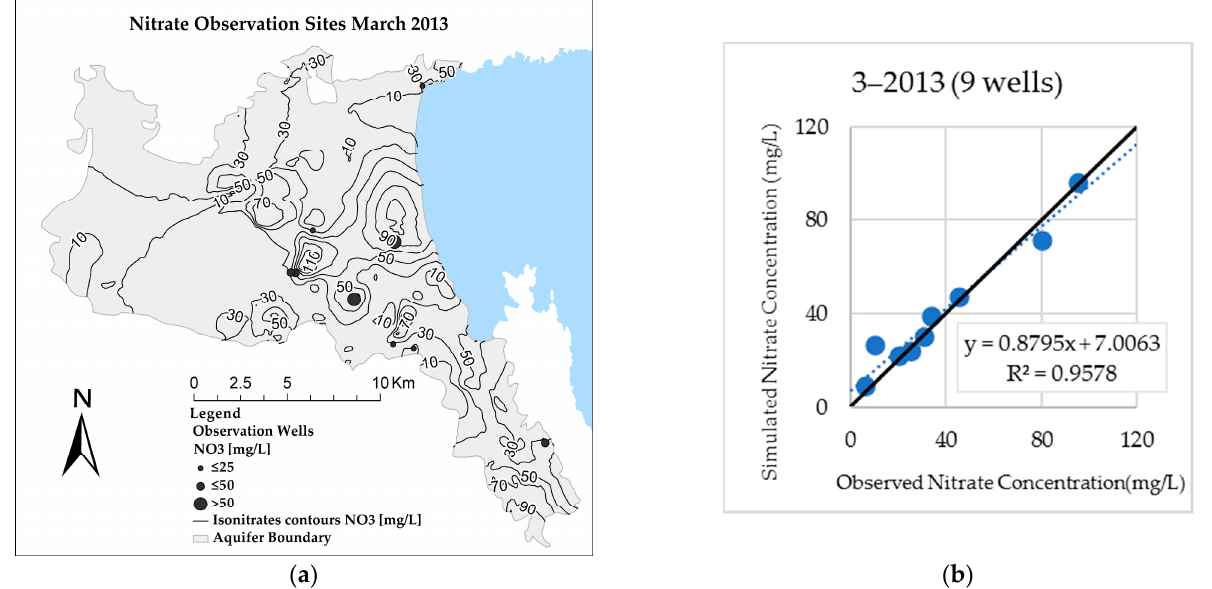
Figure 19. ( a ) Isonitrates contours for March 2013 and ( b ) scatterplot of simulated against observed nitrates concentration values.